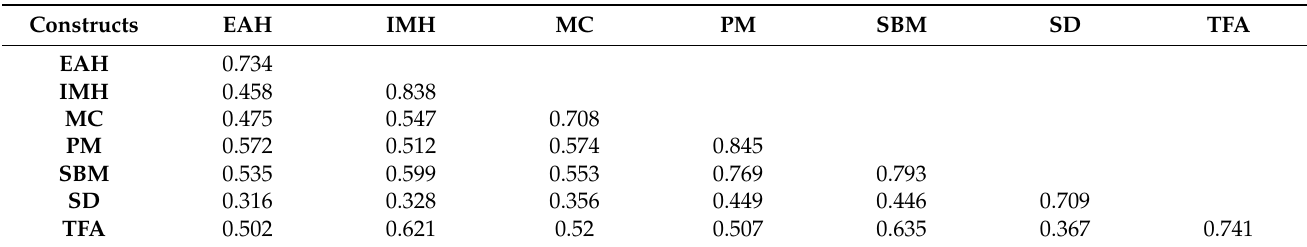
Table 3. Discriminant validity matrix.